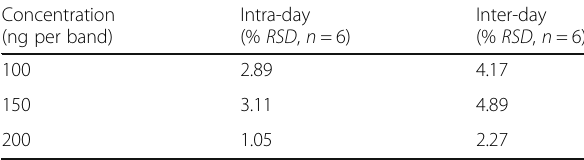
Table 2 Study of intra-day and inter-day precision for galangin